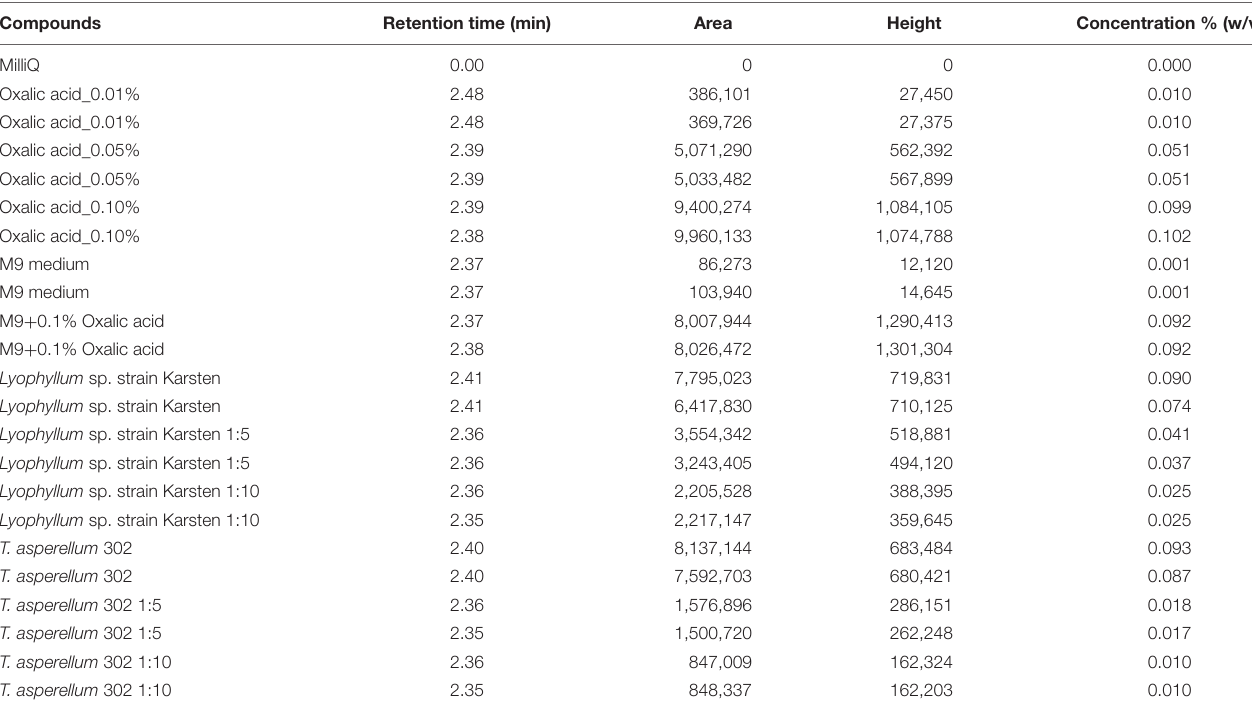
TABLE 1 | Quantitative analysis of the exudates of Lyophyllum sp. strain Karsten and Trichoderma asperellum 302 for the identification of oxalic acid, using high-performance liquid chromatography (HPLC). Oxalic acid was used as an external standard and M9 medium as a negative control. Compounds Retention time (min) Area Height Concentration % (w/v) MilliQ